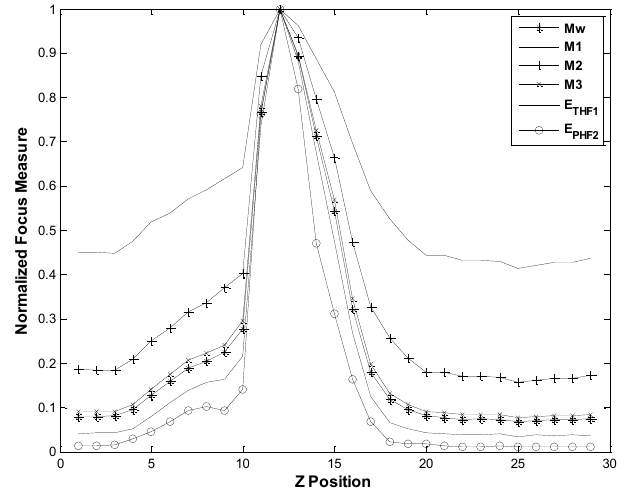
Figure 6. Comparisons of focus measures by wavelet-entropy E THF 1 , E PHF 2 and other wavelet-based functions (SNR of test image = 26 ± 0.2 dB ).